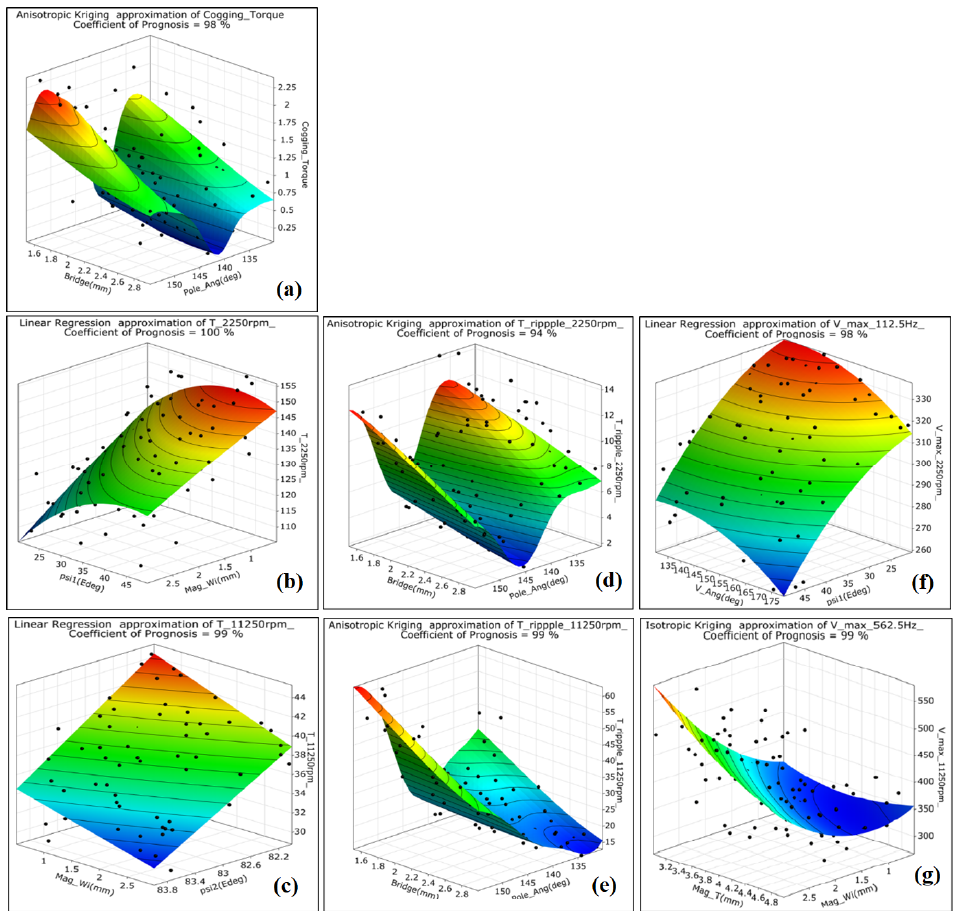
Figure 4. Response surfaces of: ( a ) cogging torque with two variables Pole_Ang (56.7%), Bridge (23.9%), variable range 0.25~2.25 N·m (±80%); ( b ) average torque (2250 rpm) with two variables Mag_Wi (36.5%), psi1 (19.7%), variable range 105~155 N-m (±19%); ( c ) average torque (11250 rpm) with two variables psi2 (61.3%), Mag_Wi (15.3%), variable range 30~44 N-m (±19%); ( d ) ripple torque (2250 rpm) with two variables Pole_Ang (67.7%), Bridge (18.8%), variable range 2~14% (±6%); ( e ) ripple torque (11250 rpm) with two variables Pole_Ang (80.8%), Bridge (18.3%), variable range 15~60% (±38%); ( f ) induced voltage (2250 rpm) with two variables psi1 (77.7%), V_Ang (16.8%), variable range 260~330 V ( ± 12%); and ( g ) induced voltage (11,250 rpm) with two variables Mag_Wi (39.7%), Mag_T (20.3%), variable range 300~550V (±30%).